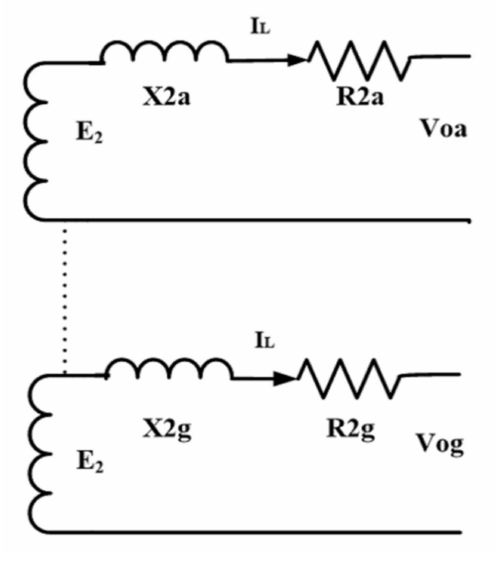
Figure 14. Exact equivalent circuit of the secondary windings.